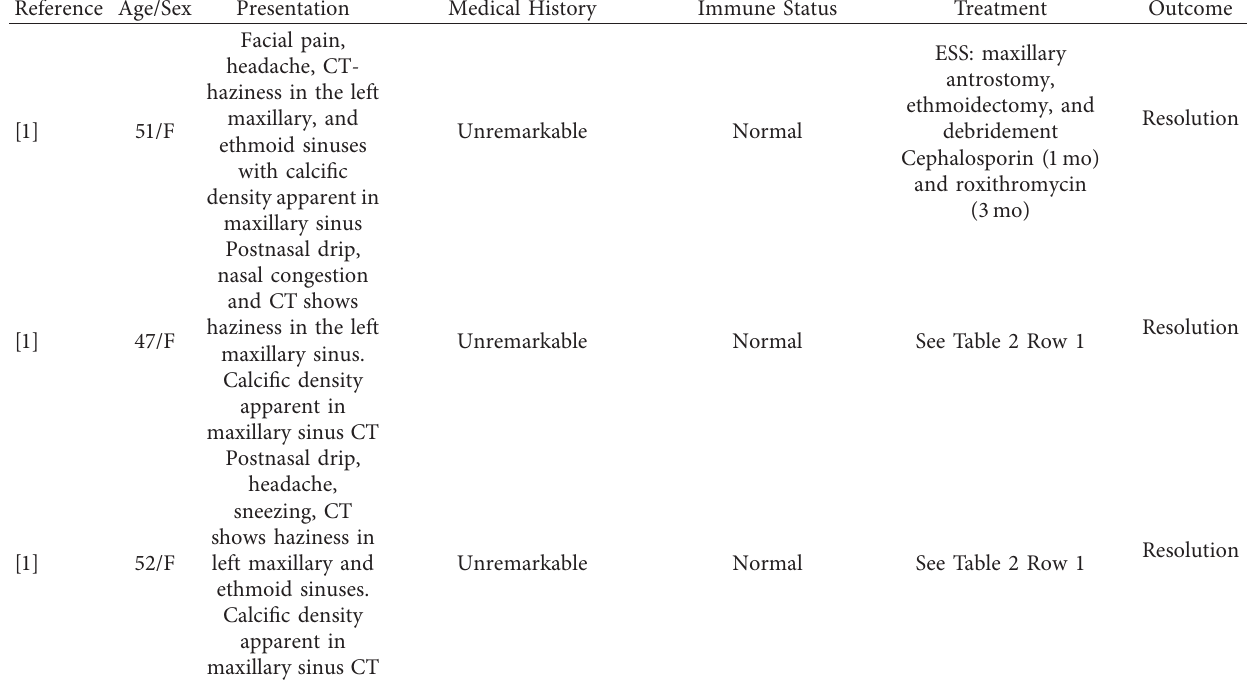
Table 2: Cases of paranasal sinus